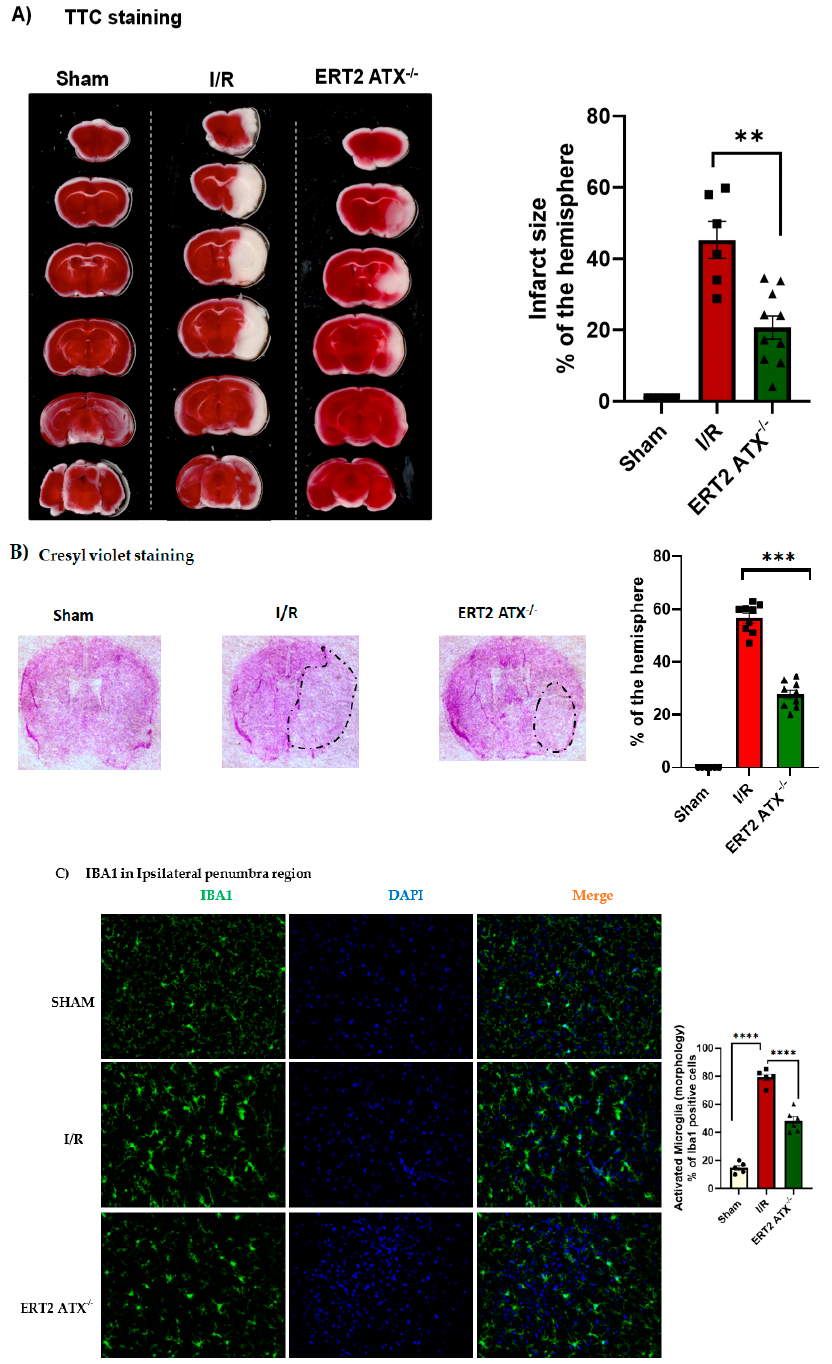
Figure 5. Infarct size post-injury decreased in ERT2 ATX − / − mice. ( A ) TTC (triphenyl tetrazolium chloride) staining was performed in mice brain slices and quantified the infarct region as a % of the ipsilateral hemisphere in sham, I/R, and ERT2 ATX − / − mice, n = 6–10. ( B ) Cresyl violet staining was performed in cryosectioned mice brain sections, and the infarct region was quantified as a % of the ipsilateral hemisphere in sham, I/R, and ERT2 ATX − / − mice, n = 6–10. ( C ) Immunostaining for IBA1 (marker for microglia) and DAPI (marker for nuclei) was performed in cryosectioned mice brain sections in sham, I/R, and ERT2 ATX − / − mice (20 × magnification). Iba-1-positive cells were characterized morphologically according to their activation/resting state and expressed as a percent of their total number, n = 5–6. All values are mean ± SEM ( n = 6–10). ** p < 0.01, *** p < 0.001, and **** p < 0.0001 compared to I/R using a Mann–Whitney U